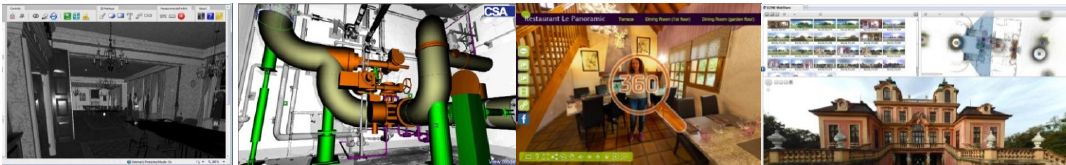
Figure 14. Examples of user interfaces that can be found today for virtual tours: Leica TrueView, CSA VirtualTours, Kolor PanoTour, Faro WebShare.